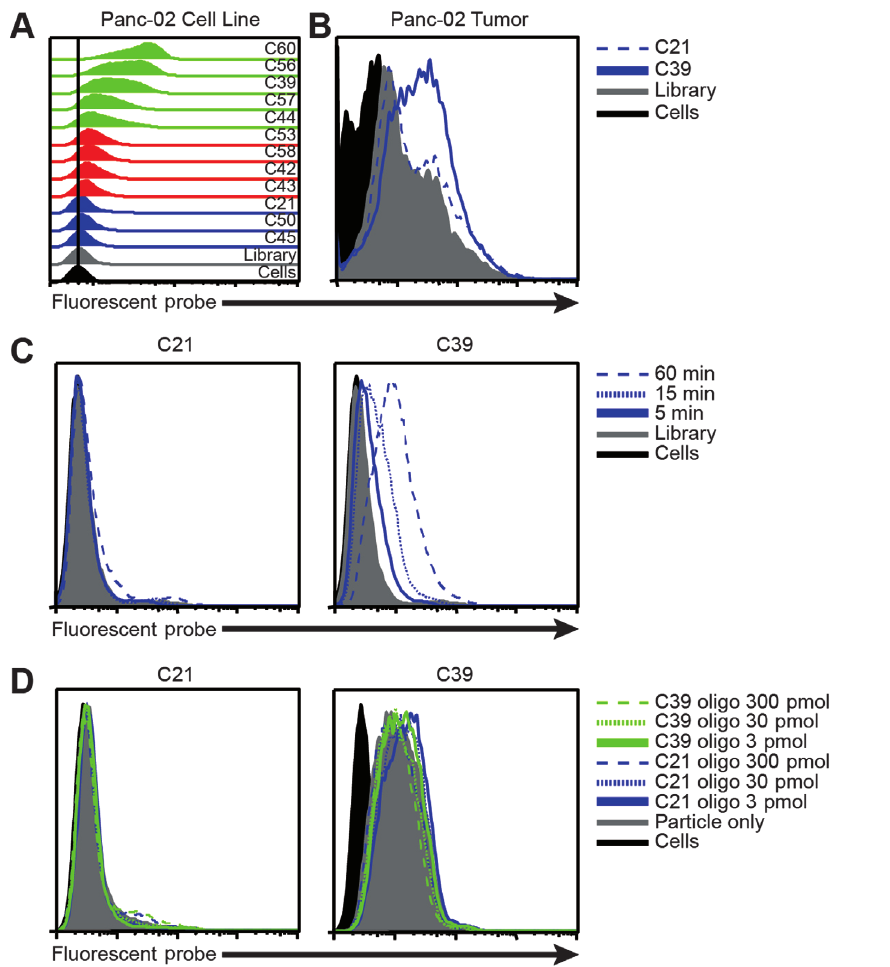
Figure 3 Cell staining with Panc-02-selected DeNAno clones. (A) Staining of Panc-02 cell line with 12 of the clones and library. 9B) Staining of a Panc-02 subcutaneous tumor ex vivo with library and Panc-02-selected clones C39 and C21. (C) Staining of Panc-02 cell line with C21 and C39 clones synthesized for 5, 15, or 60 min. (D) Panc-02 cell line pre-incubated with C21 or C39 100-bp oligos, followed by staining with DeNAno particle C21 (left panel) or C39 (right